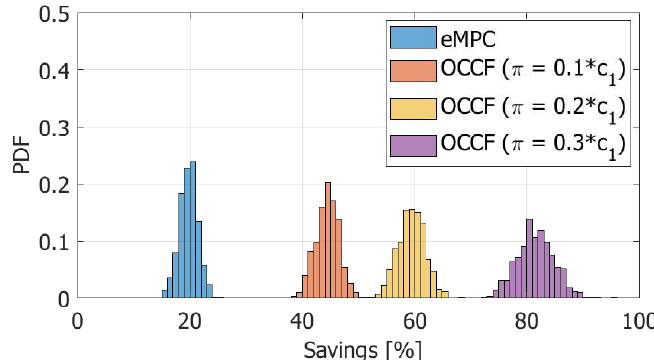
Figure 10. Overall savings for different strategies and remuneration factors based on c 1 .